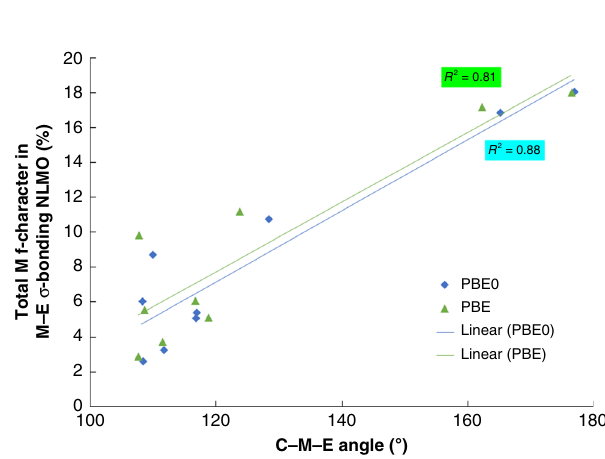
Fig. 7 The C-M-E angle (°) vs the total metal f character in the M-E σ bonding NLMO (%) of [C] = M = E. C = C(PH 2 NSiH 3 ) 2 ; M = Ce, Th, U; E = C (CH 3 ) 2 , NCH 3 , O). R 2 with PBE0 (PBE) for Ce, Th, and U are 0.93 (0.83), 0.97 (0.96), and 0.96 (0.88), respectively